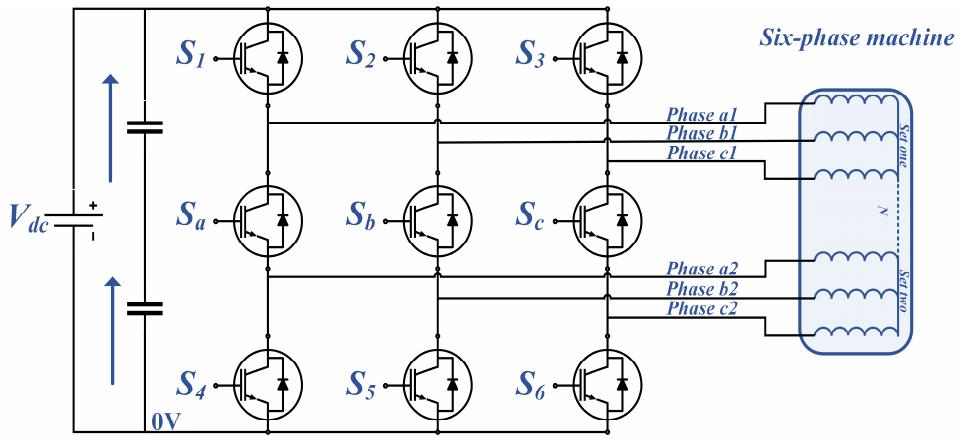
Figure 17. Six-phase, nine switch topology for a six-phase voltage source drive.